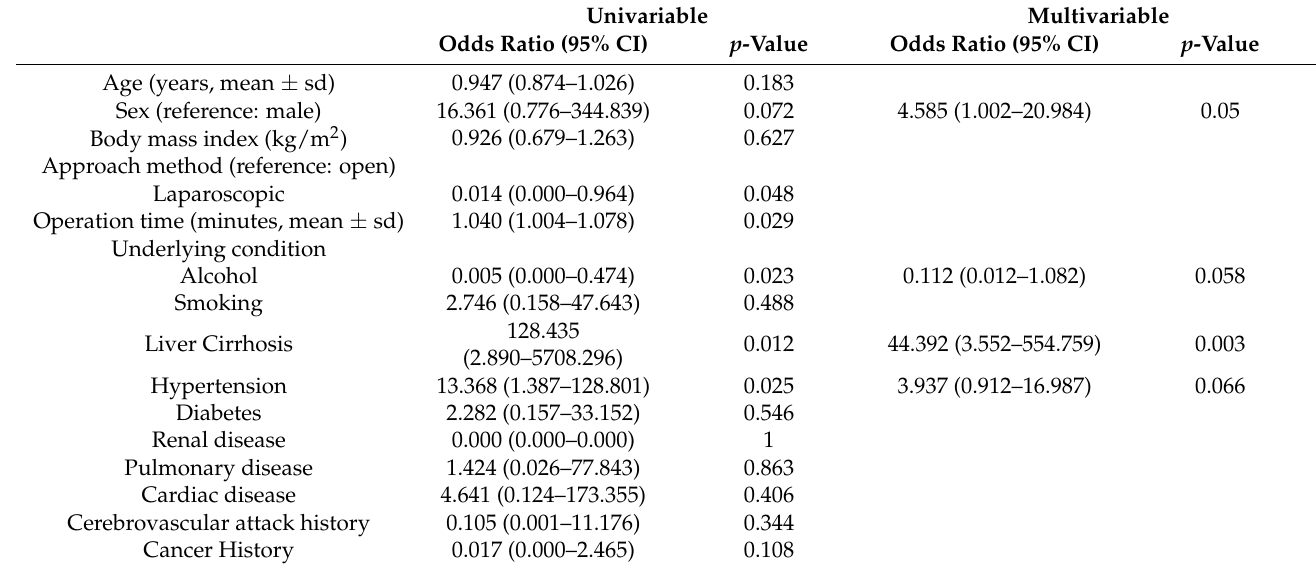
Table 3. Factors that associated with severe complications * (Clavien-Dindo classification IV and V).